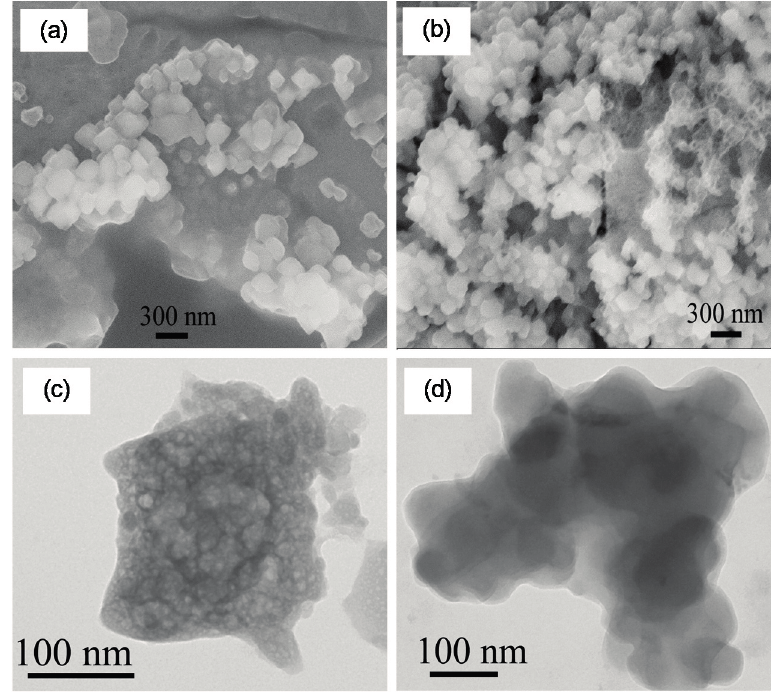
Figure 2. Microscopy images of chemically-synthesized magnetic nanoparticles: SEM ( a ) Fe–Gd–O; ( b ) Fe–Ho–O; and TEM ( c ) Fe–Gd–O; ( d )